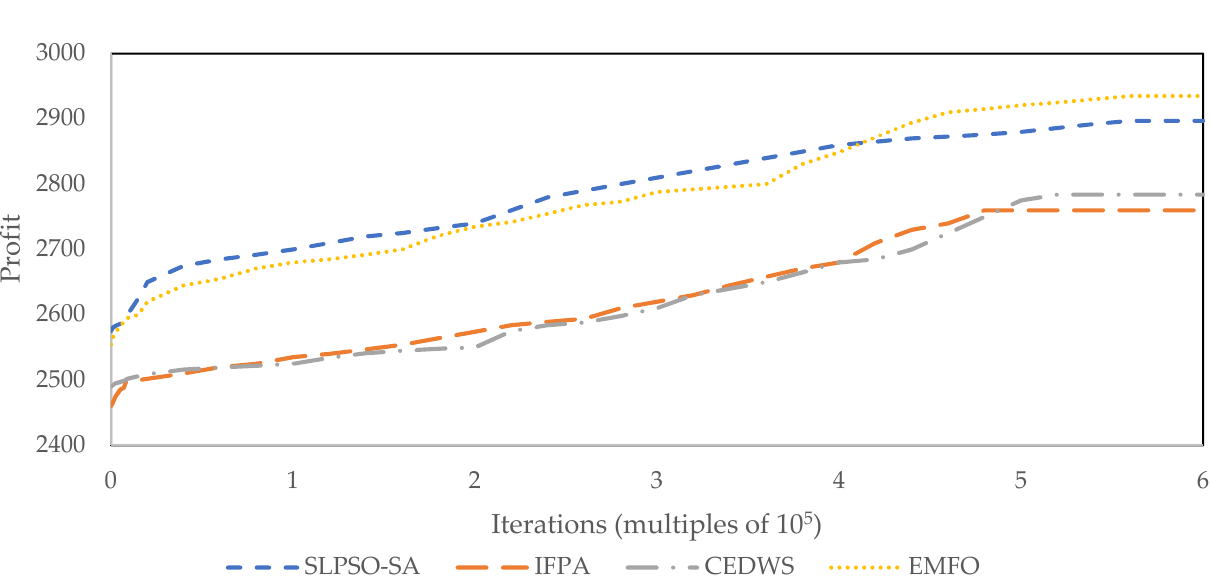
Figure 3. Convergence characteristics of algorithms for instance type 2.